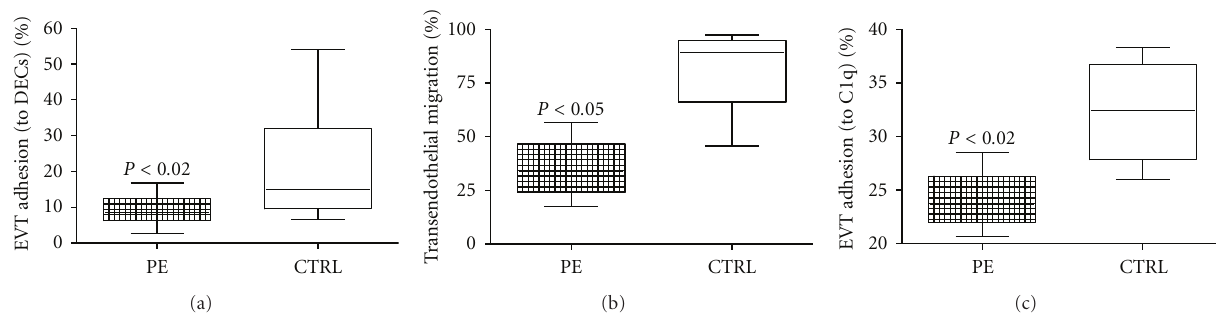
Figure 2: E ff ect of serum from pre-eclamptic and normal pregnant women in EVT/DEC interaction. Analysis of the e ff ect of sera obtained from PE or normal women on the adhesion of EVTs to DECs (a), to C1q (c) and on transendothelial migration through DECs (b). EVTs were preincubated with PE or control sera (1:50). The results are expressed as percent of adhesion in reference to a standard curve. For each group, the line in the middle of the box represents the median. The lower and the upper edges of the box are the 1st and 3rd quartile, respectively.